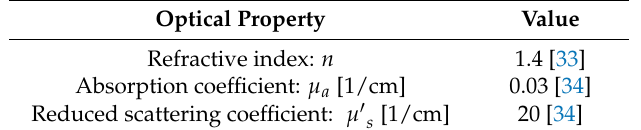
Table 1. Optical properties of POM at wavelength of 785 nm.